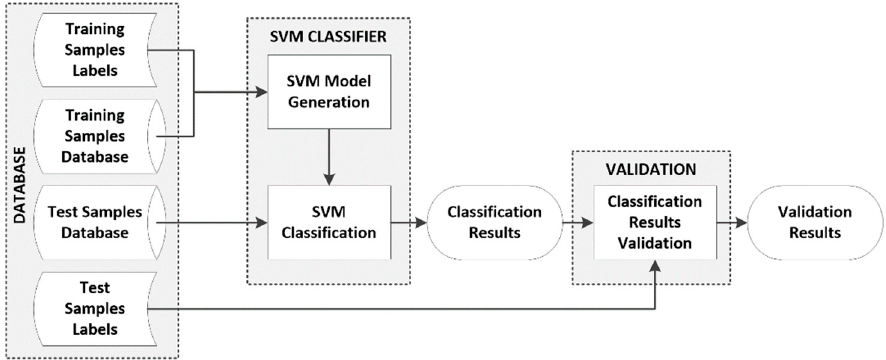
Figure 2. Block diagram of the classification framework.